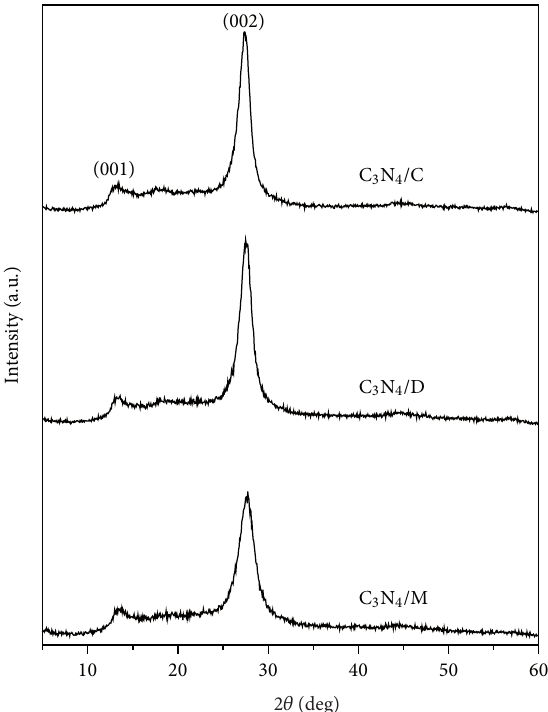
F 1: XRD patterns for g-C sors.